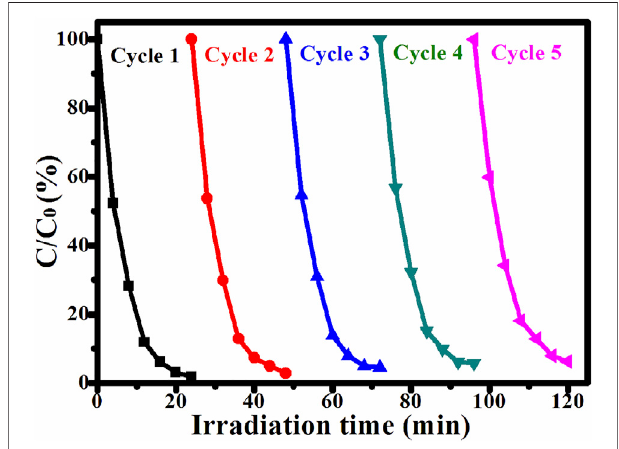
Frontiers in Chemistry |